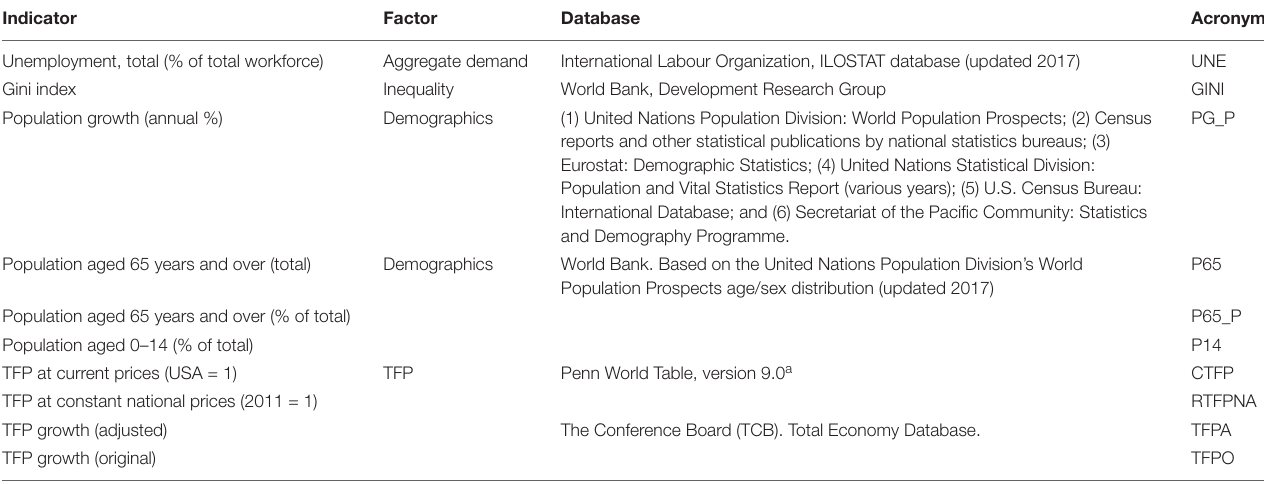
TABLE 3 | Variables corresponding to the structural factors explaining secular stagnation.